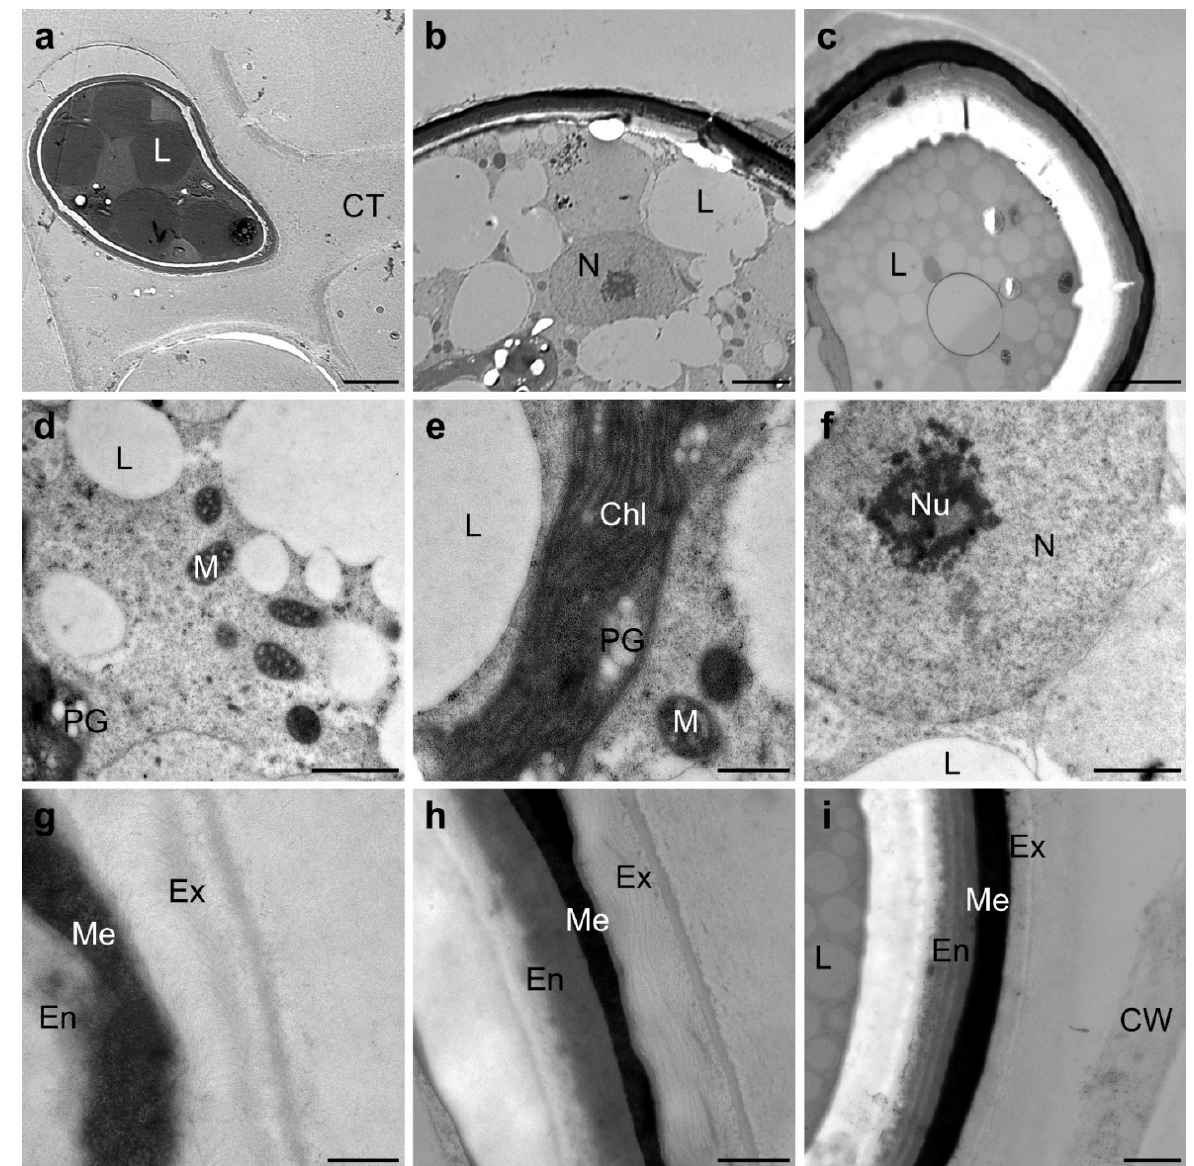
Figure 4. Transmission electron micrographs of zygospores of Spirogyra mirabilis : ( a ) gametangia with zygospore and conjugation tube, ( b ) overview of mature zygospore, ( c ) mature zygospore with lipid accumulation, ( d ) mitochondria and lipid bodies in the cell lumen, ( e ) detailed view of the chloroplast lobes with plastoglobuli, ( f ) nucleus with nucleolus, ( g ) detailed view of the zygospore wall of a presumably young zygospore with visible exospore structure, ( h ) mature zygospore wall, ( i ) mature zygospore with distinct orientation of the microfibrils of the endospore. Abbreviations: Chl—chloroplast, CT—conjugation tube, CW—cell wall of the gametangium, En—endospore, Ex—exospore, L—lipid bodies, Me—mesospore, M—mitochondrion, N—nucleus, Nu—nucleolus, PG—plastoglobuli. Scale bars ( a ) 5 µm, ( b , c ) 2500 nm, ( d , f , i ) 1 µm, ( e , g , h ) 500 nm .